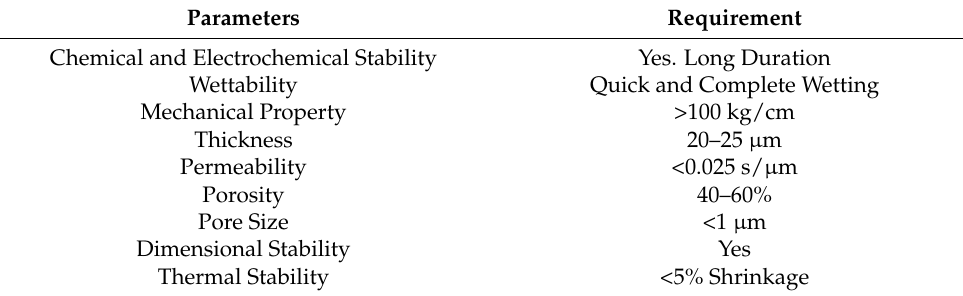
Table 1. Parameters and requirements for separators [123,124]. Parameters Requirement Chemical and Electrochemical